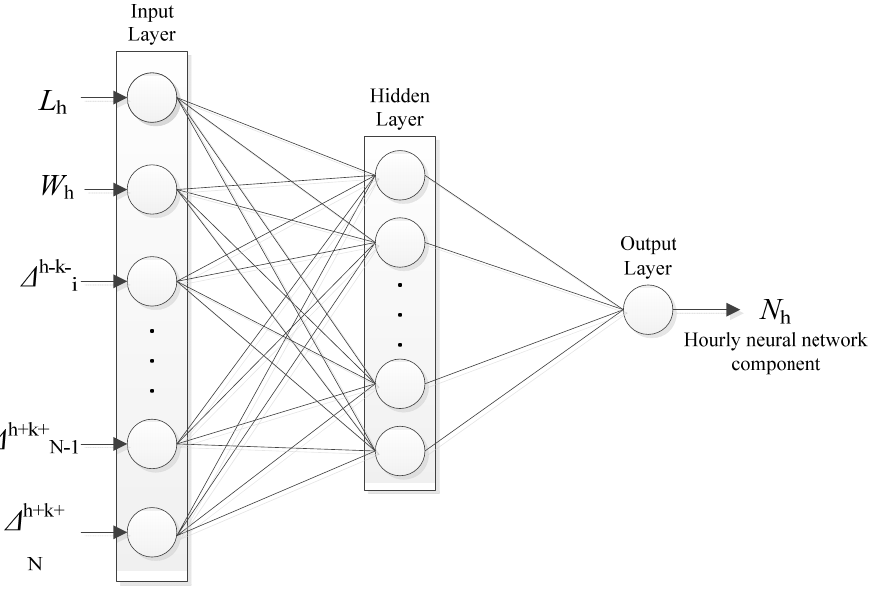
Figure 6. Defining the data set for the forecasted hour h